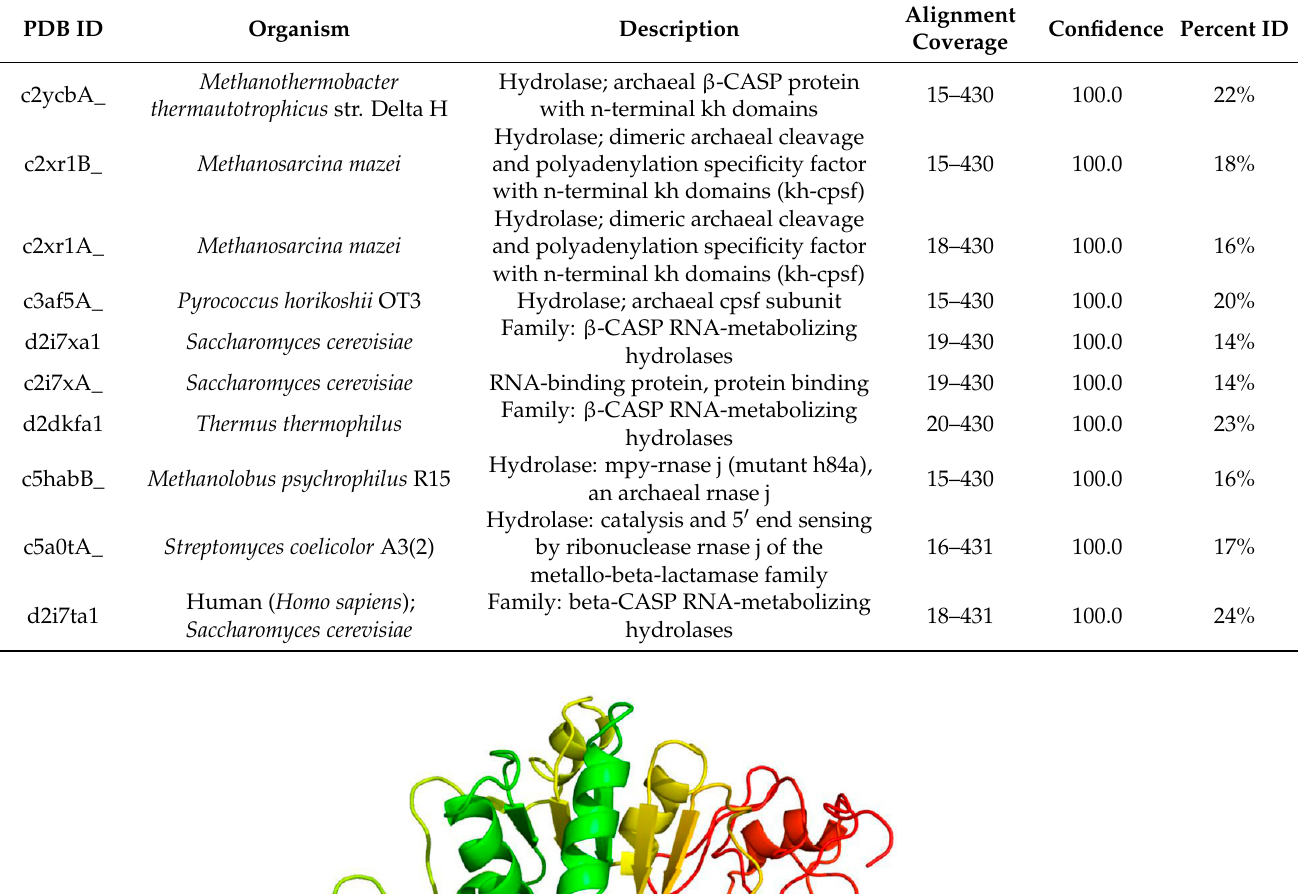
Table 1. Phyre2 top hits for the PsoR sequence. The PsoR amino acid sequence from Fremyella diplosiphon was submitted to the Phyre2 Protein Fold Recognition Server. Multiple hits were retrieved with similarities to the Ysh1 superfamily of proteins. ID = identity.